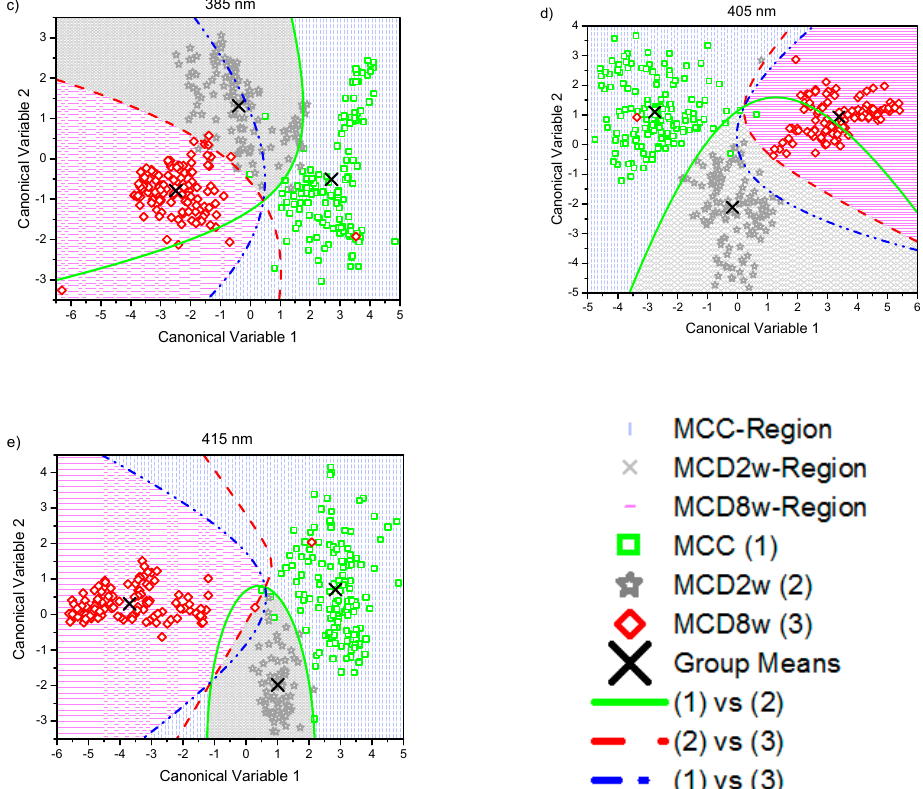
Figure 3. Canonical score plots obtained by the quadratic discriminant analysis (QDA) applied to the six firsts principal component (PC) values obtained from all observed spectra normalized at 600 nm using excitation lights of: ( a ) 330 nm, ( b ) 365 nm, ( c ) 385 nm, ( d ) 405 nm, and ( e ) 415 nm. Distribution of every single collected measurement are represented for every group in their corresponding regions: MCC (green squares in blue pattern), MCD2w (gray stars in gray pattern), and MCD8w (red diamonds in pink pattern). The mean value of each group is represented by an “ × .” The curved lines mark the boundaries between regions. The inset in the lower right corner serves as a common legend to all the graphs.